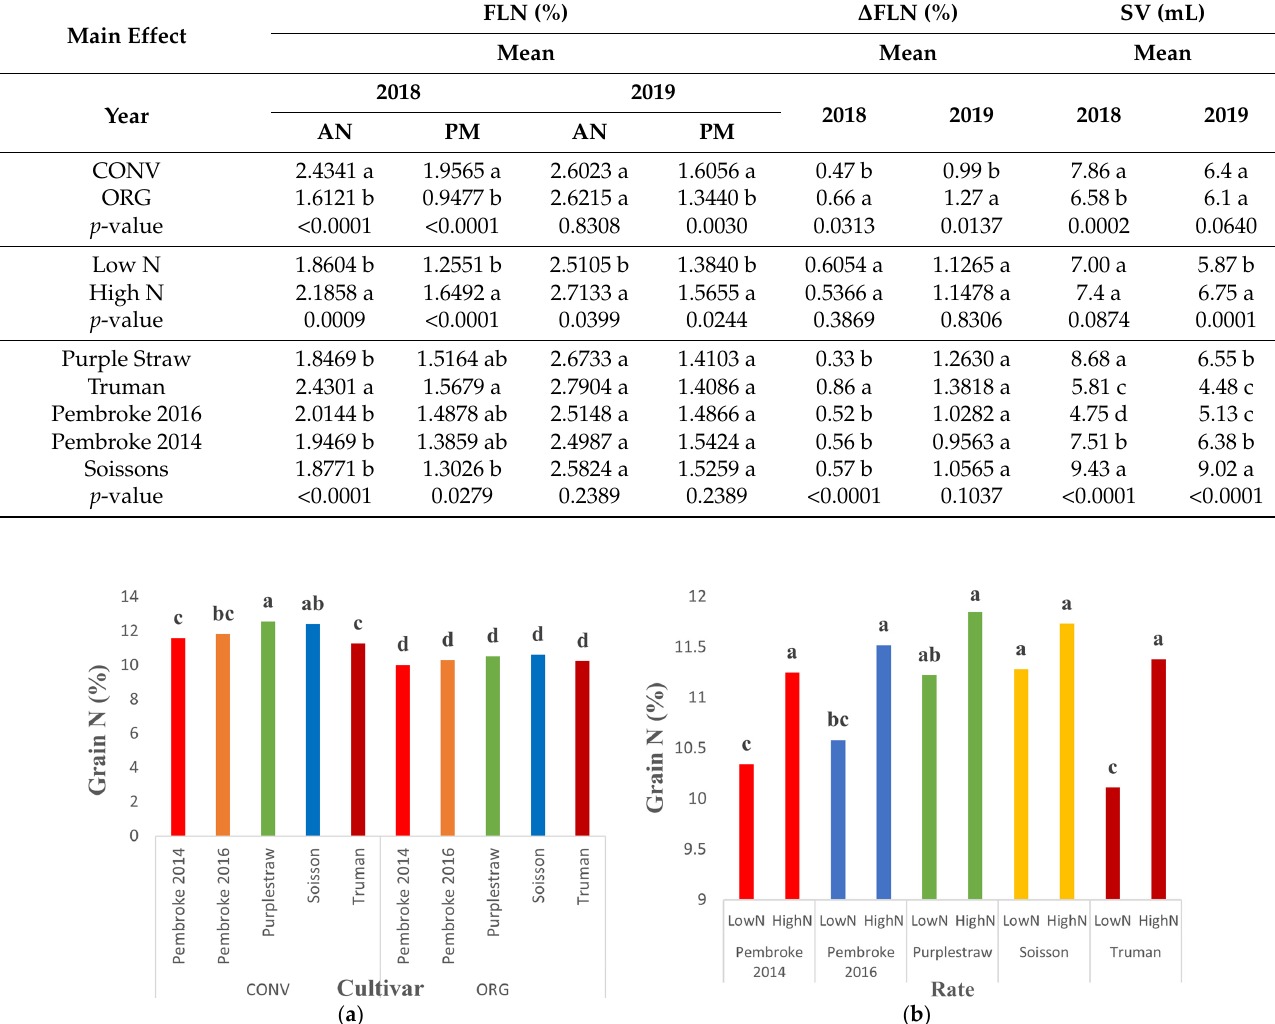
Table 7. Flag leaf nitrogen (FLN, %) at anthesis (AN) and physiological maturity (PM), change in flag leaf nitrogen ( ∆ FLN, %) and sedimentation value (SV, mL). (Same letters within each column and main effect are not significantly different based on Tukey’s honest significant difference (HSD) test performed at α = 0.05).